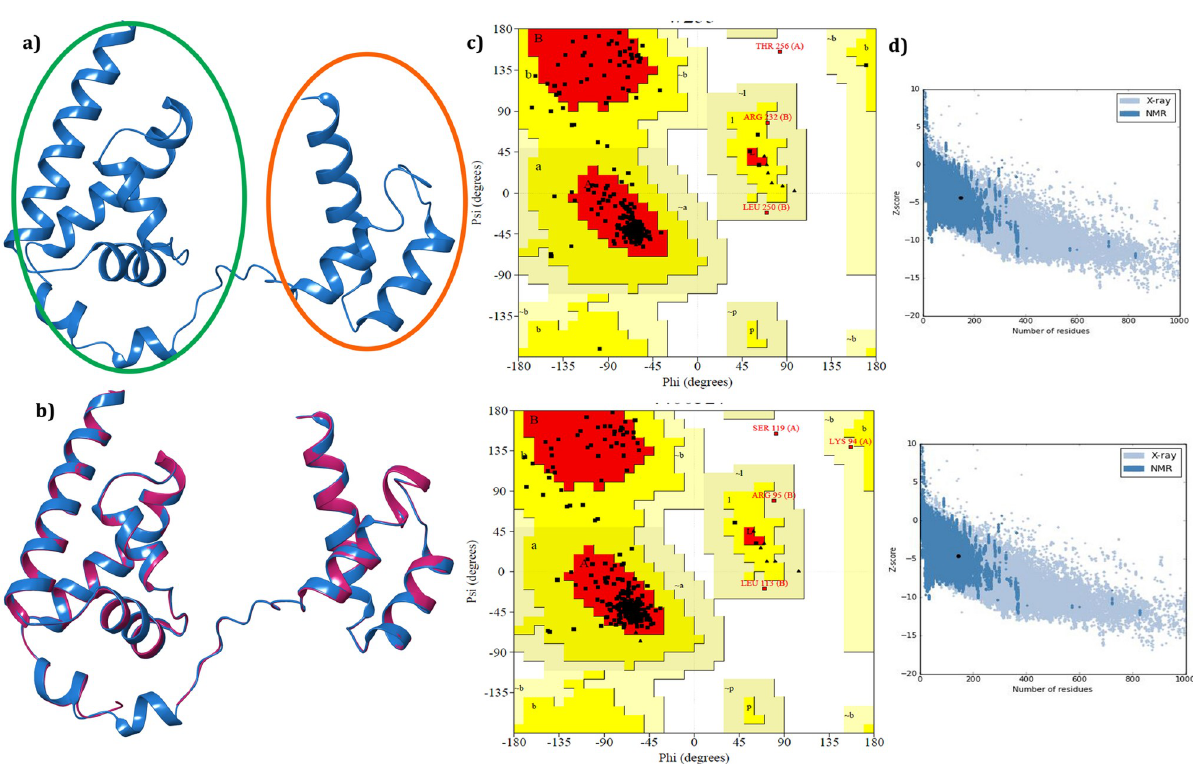
Fig 3. Best 3D structure of the homology model Oct4 and validation result. a) Model structure predicted through modeler where green color circle represented the POUs domain and red color showed POU H domain. b) Structural alignment of model structure with the crystal structure (PDB ID: 3L1P) where model structure displayed in blue color and crystal structure in deep pink color; c) Ramachandran plot for model structure (top) and template structure (3L1P) (bottom) showing the energetically allowed regions for backbone dihedral angles ψ against ϕ of amino acid residues; d) The calculated quality (Z) scores generated by ProSA in the context of all experimentally determined protein structures. The top panel Fig represents the modeled structure and the bottom panel represents the template structure (PDB ID: 3L1P).